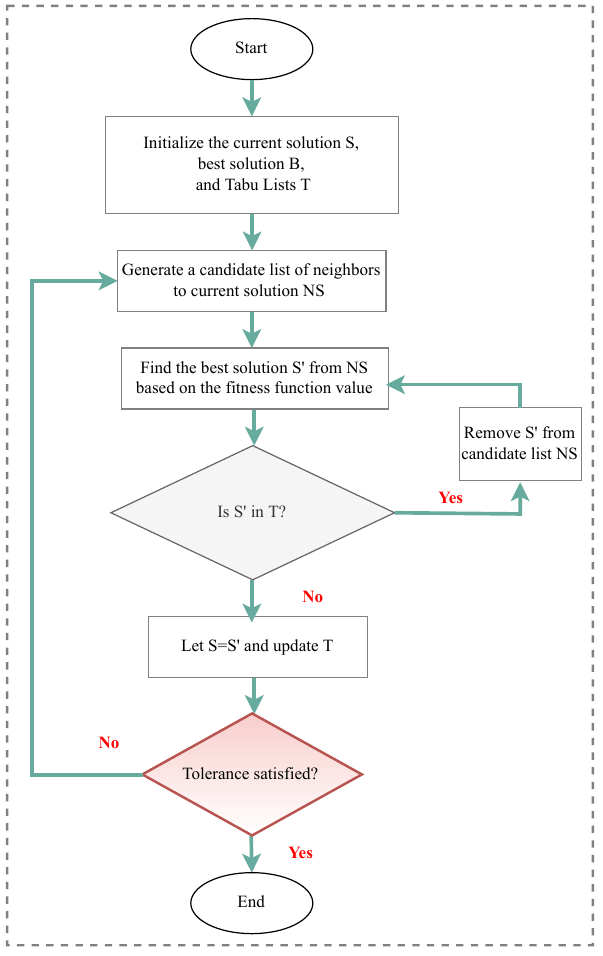
Figure 16. Flowchart of